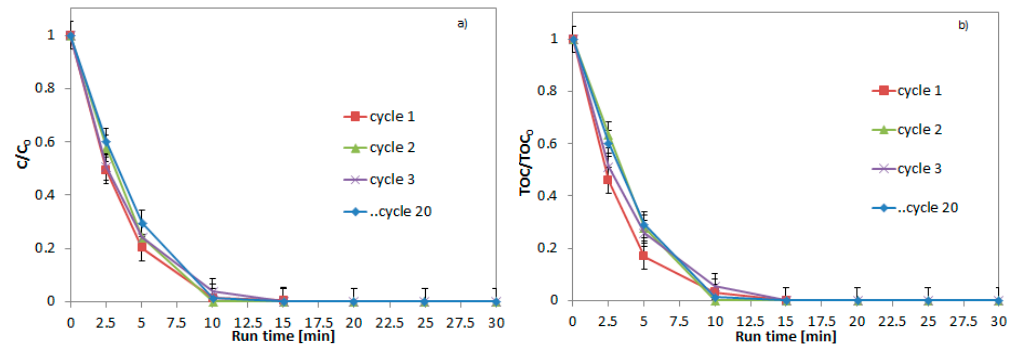
Figure 6. Recyclability tests for SF2 catalyst in terms of AO7 discoloration ( a ) and mineralization ( b ). AO7 initial concentration: 20 mg/L. Glass spheres amount: 36 g. Applied voltage: 12kV. O 2 flow rate: 0.18 NL/min.